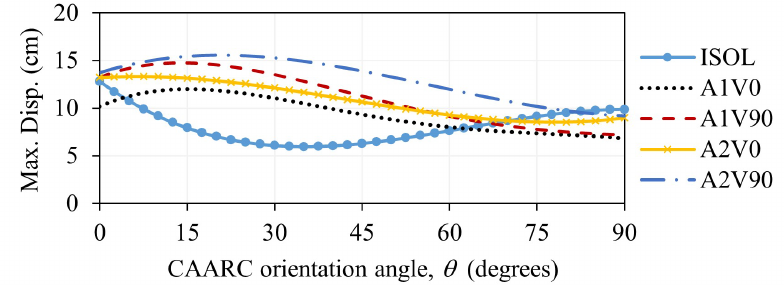
Figure 14. Maximum displacement at the top of the CAARC, y-direction.